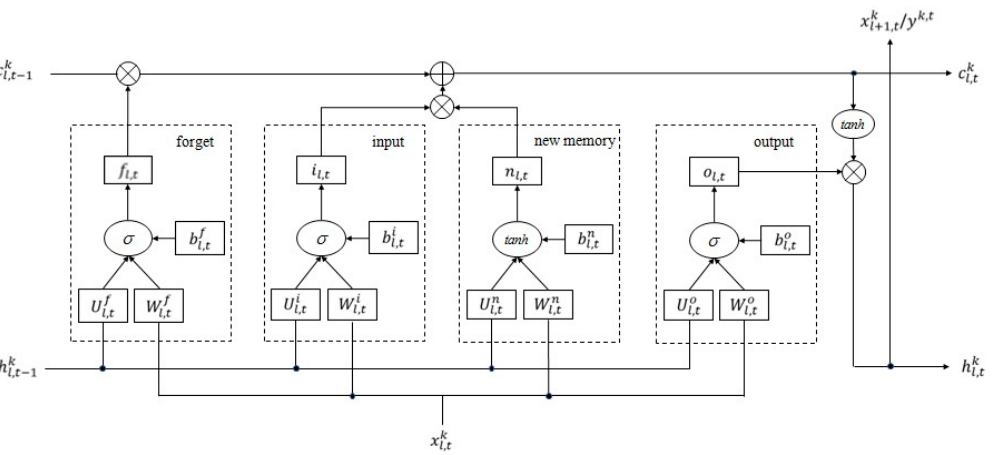
Figure 3. The internal structure of a LSTM cell [47].